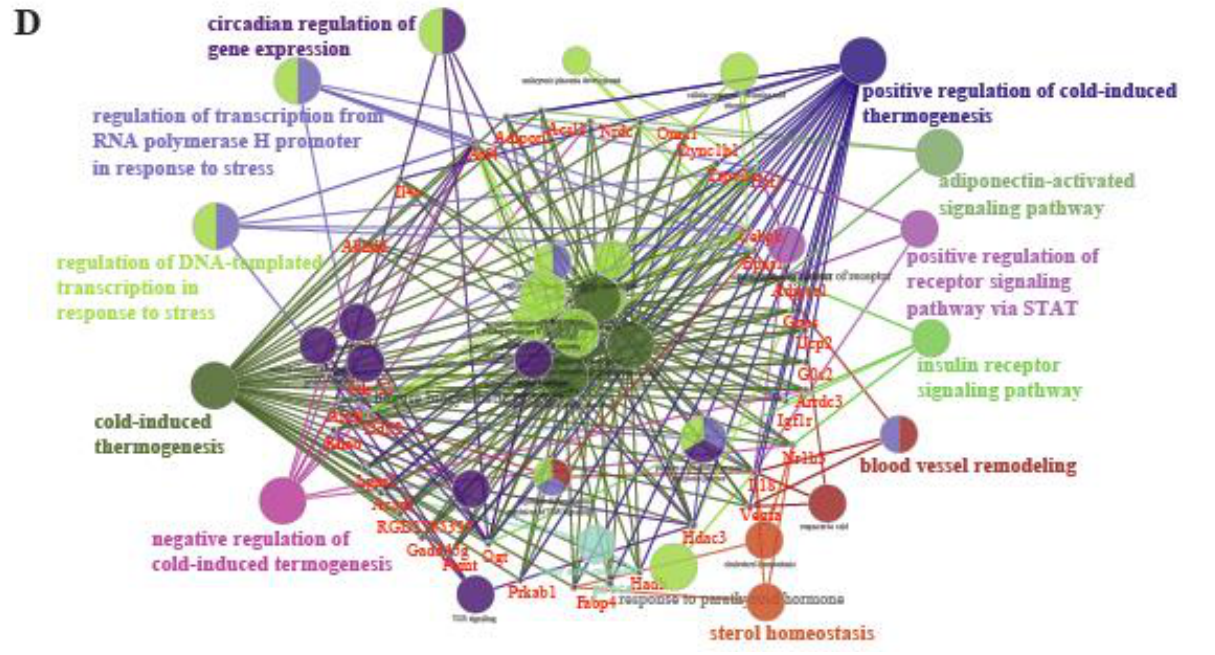
Figure 4. Analysis of genes in adrenal glands engaged in thermal regulation processes. ( A ) Venn diagram of the genes involved in process of response to heat (GO: 0009408). ( B ) Venn diagram of the genes involved in the process of cold-induced thermogenesis (GO: 0106106). ( C ) Functional annotation of genes enriched in the process of the response to heat. The GO-BP terms with p ≤ 0.01 were regarded as significant. ( D ) Functional annotation of genes enriched in the process of cold- induced thermogenesis. The GO-BP terms with p ≤ 0.01 were regarded as